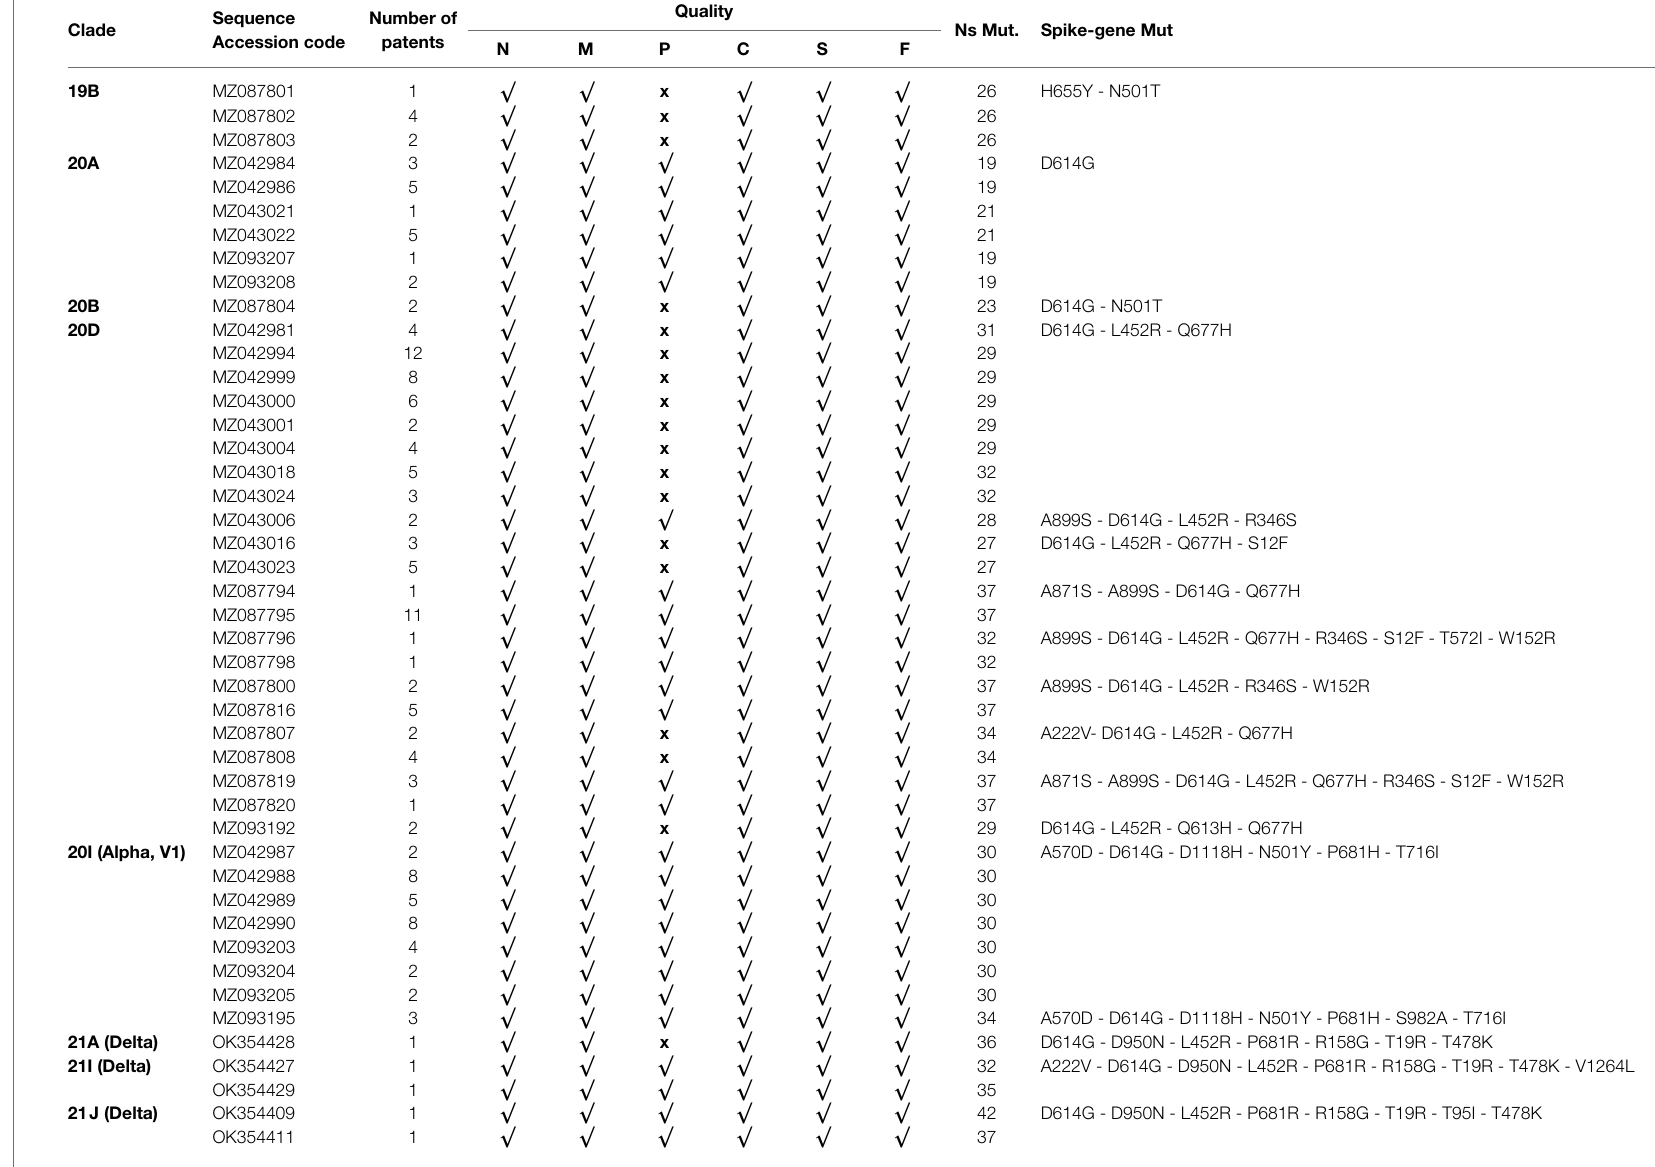
TABLE 2 | Spike-gene mutations of the sequences involved in the study. Sequence Number of Clade Accession code